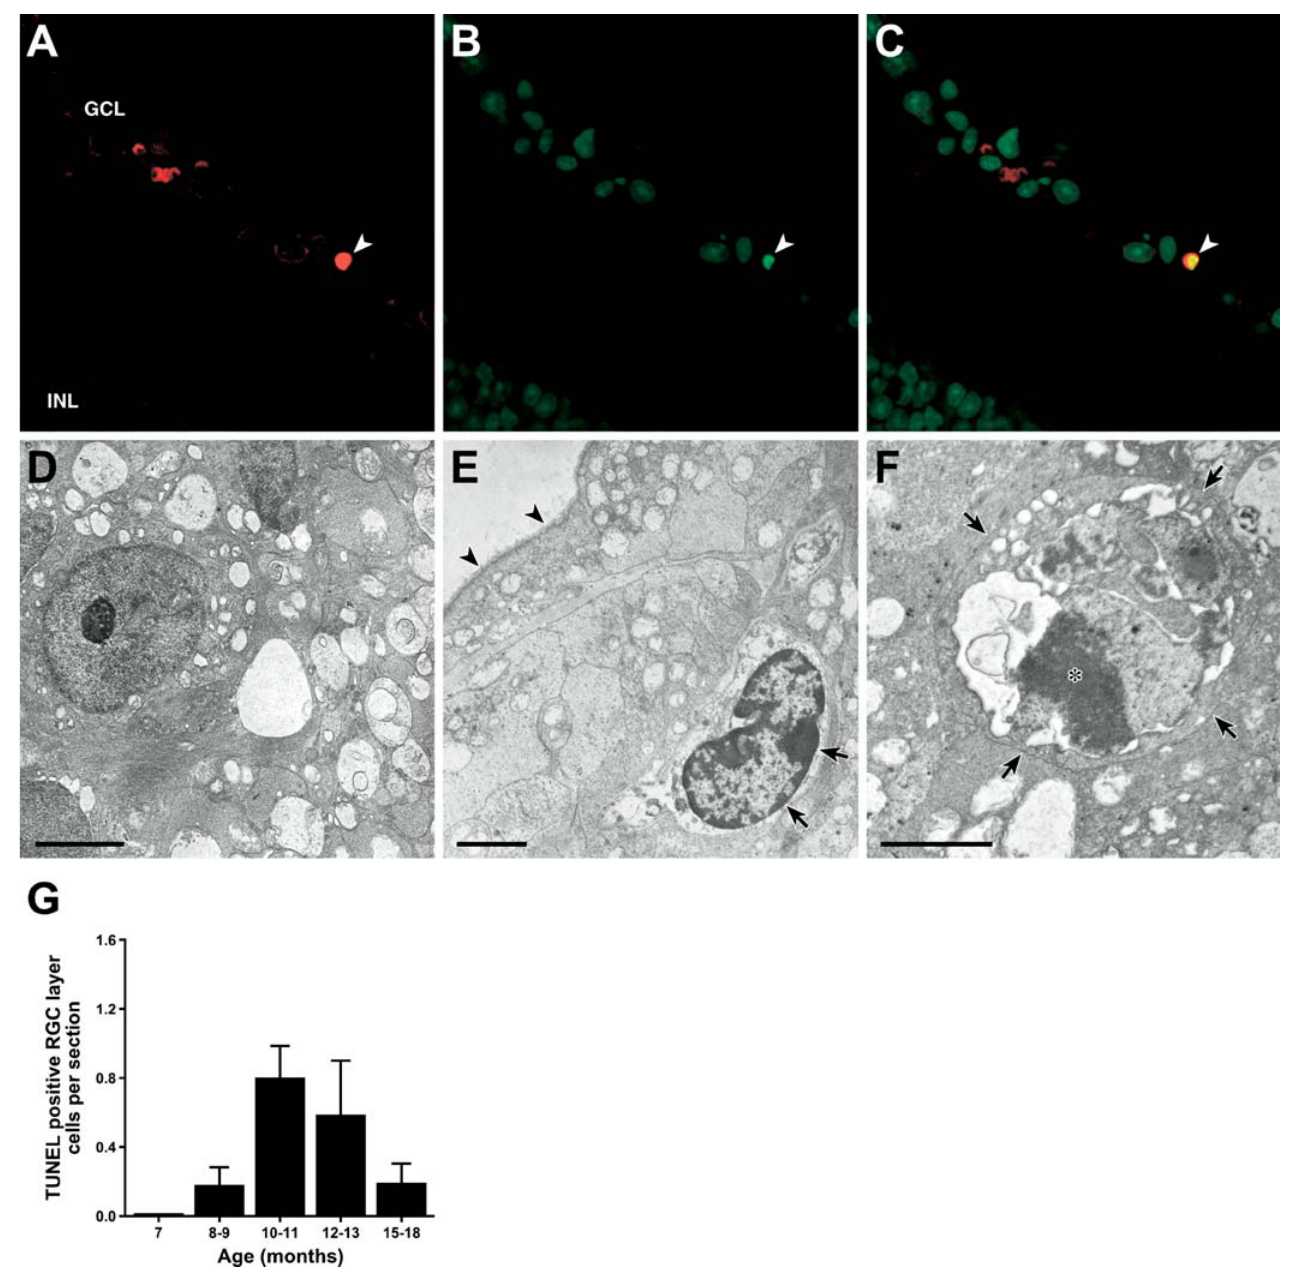
Figure 1. Dying RGCs Have Characteristic Features of Apoptosis (A–C) A double-labeling assay that identifies fragmented DNA using fluorescently labeled dUTP (A) and detects chromatin condensation by binding of the dye YOYO-1 (B) was used to assess the presence of these hallmarks of apoptosis in glaucomatous DBA/2J eyes at 10–11 mo of age (a time when many RGCs die). A cell in the retinal ganglion cell layer (GCL, arrowhead) has both of these features of apoptosis as indicated by double labeling (C). INL, inner nuclear layer. (D–F) Electron microscopy provided further evidence for apoptosis. (D) An example of a healthy RGC. (E) Chromatin condensation (a hallmark of apoptosis) along the inner surface of the nuclear envelope in a ganglion cell (arrows). The internal limiting membrane of the retina is indicated by arrowheads. (F) An apoptotic body in the ganglion cell layer (arrows) containing a nuclear fragment with prominent condensed chromatin (asterisk) and other cell remnants. (G) A TUNEL assay (see Materials and Methods) was used to assess the prevalence of cell death at different ages. TUNEL labeling was not detected at 7 mo (an age prior to glaucomatous cell death) and peaked at 10–13 mo, when most RGCs die. No TUNEL-positive cells were detected in nonglaucomatous, age-matched control mice. These results support an important role of apoptosis in RGC death in spontaneous glaucoma. Scale bar, 1 l m. DOI: